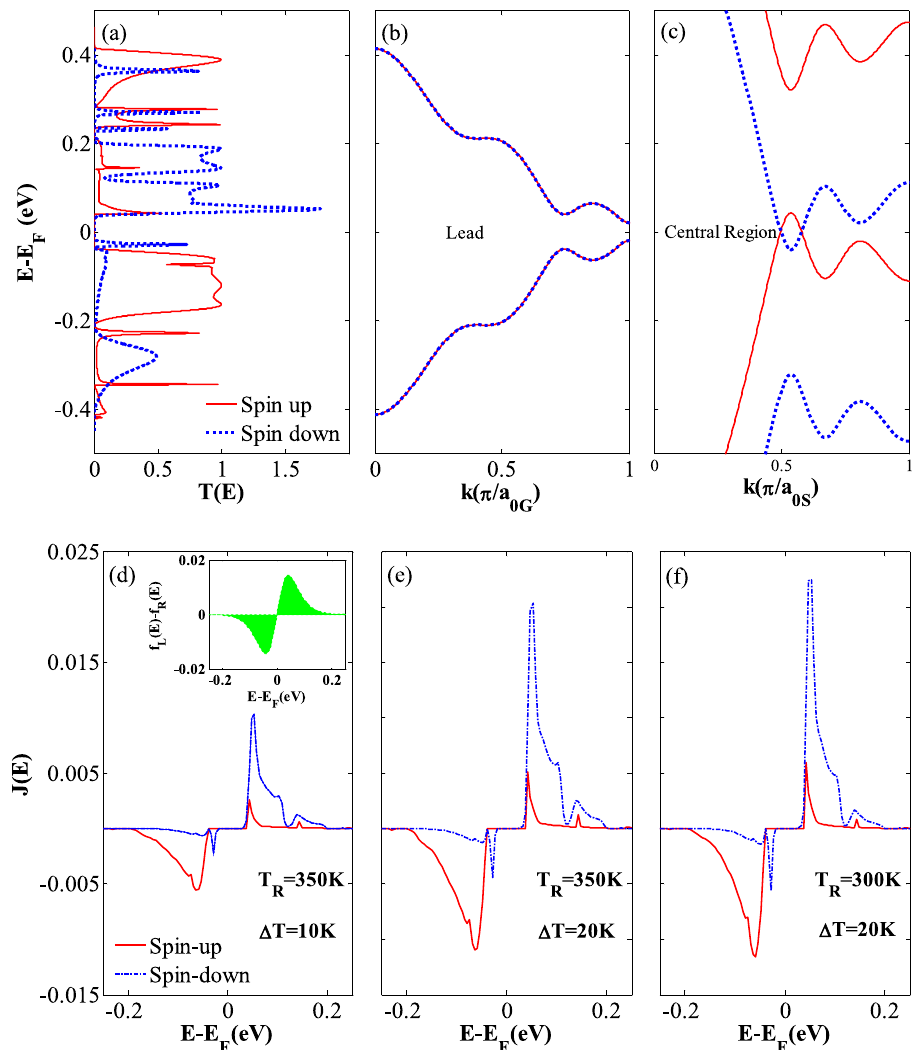
Figure 3. ( a ) The spin-dependent transmission spectra ( T up and T dn ) versus E − E F , ( b ) the band structures of the right (left) lead with an applied electric field of E y G = 0.913 V/Å, ( c ) the band structures of the ferromagnetic central region including an exchange field of M z = 0.181 eV, electric fields of E Z = 0.081 V/Å and E y S = 0.127 V/Å, and the variation of the spin-dependent current spectrum J ( E ) versus E − E F for ( d ) T R = 350 and ∆ T = 10 K, (inset shows the difference between the Fermi–Dirac distributions for the left and right leads, f L ( E )- f R ( E ), as a function of E − E F ), ( e ) T R = 350 and ∆ T = 20 K, and ( f ) T R = 300 and ∆ T = 20